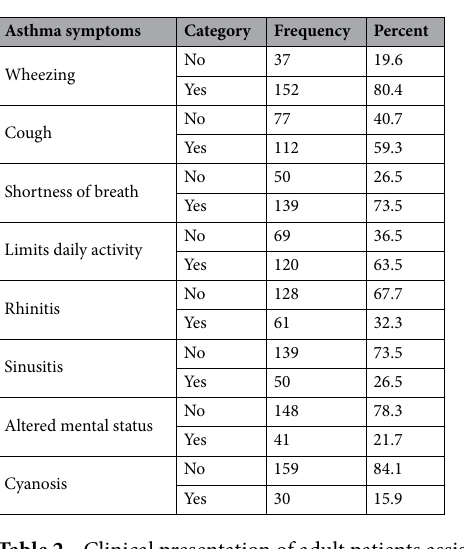
Table 2. Clinical presentation of adult patients assisted at the Adult Emergency Department of the Jimma Medical Center, Jimma Town, Ethiopia during 25 July, 2021 to 25 August, 2021.